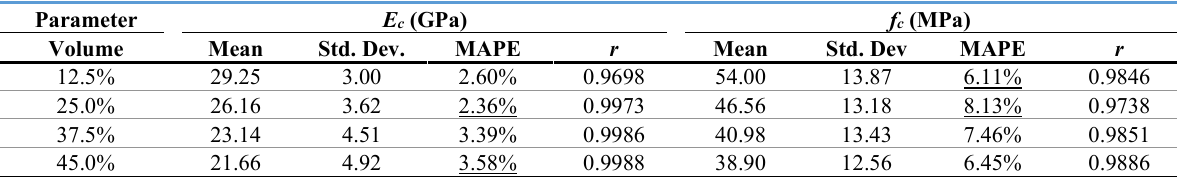
Table 6 N umerical results of the mechanical properties (Young’s modulus, E c ; and compressive strength, f c ) for each aggregate volume; including MAPE and Pearson correlation coefficient ( r ) statistical